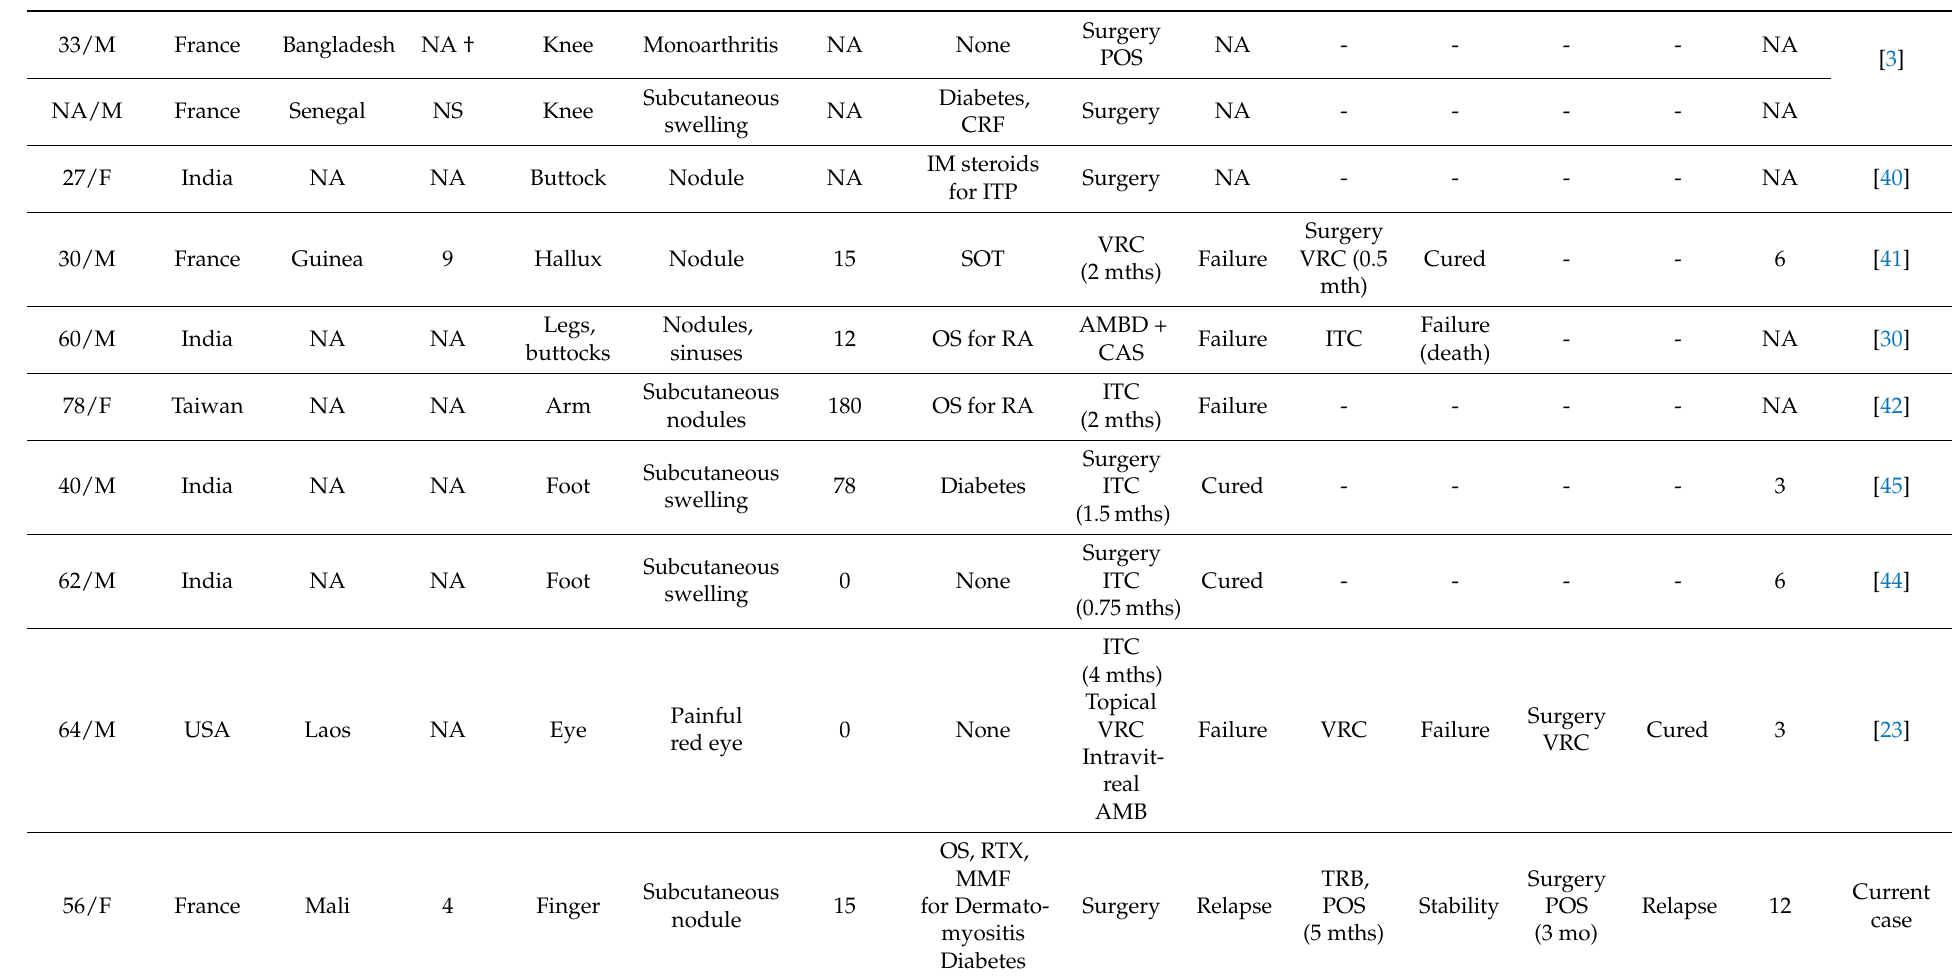
IVIG: intravenous immunoglobulins, ITC: Itraconazole, LAD: Linear IgA dermatosis, LAMB: liposomal Amphotericin B, M: male, mth: month, MMF: mycophenolate mofetil, MTX: Methotrexate, NA: not available, OS: oral steroids, POS: Posaconazole, RA: rheumatoid arthritis, RTX: Rituximab, SOT: solid organ transplantation, Tac: Tacrolimus,